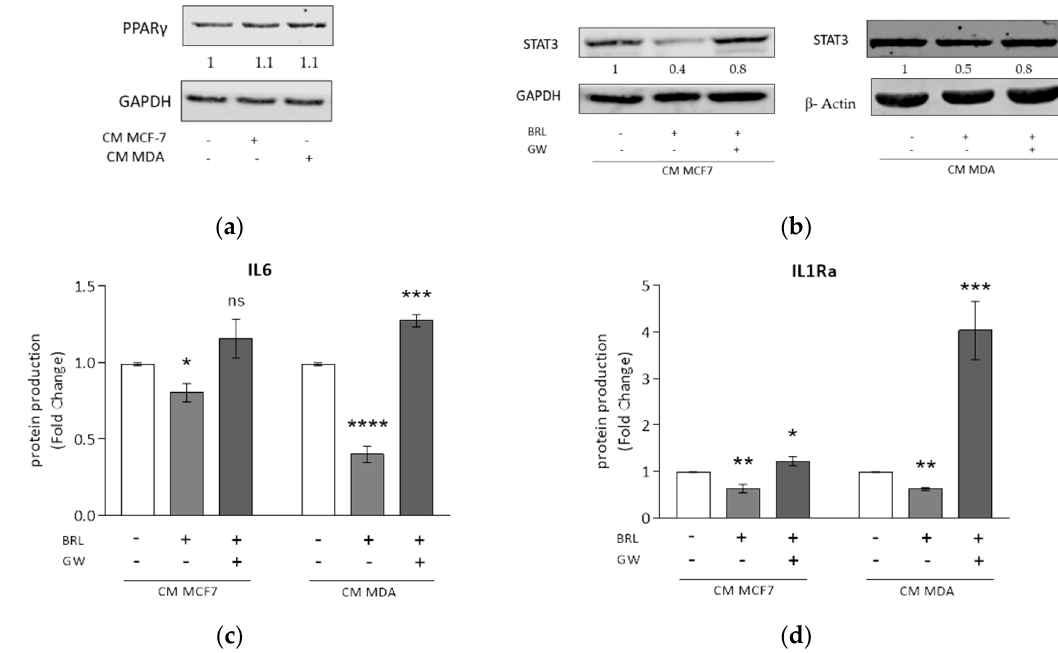
Figure 3. Rosiglitazone antagonizes macrophage cytokine secretion induced by conditioned media derived from MCF7 and MDA-MB-231 breast cancer cells. ( a ) Immunoblotting of PPAR γ in M0 macrophages (-) incubated with CM MCF7 or CM MDA for 72 h. Glyceraldehyde-3-phosphate dehydrogenase (GAPDH) was used as loading control. The blot is representative of three independent experiments, while the numbers below the blots represent the average fold change between PPAR γ and GAPDH protein expression with respect to M0 macrophages. ( b ) Immunoblotting of STAT3 in M0 macrophages incubated with CM MCF7 or CM MDA and treated with rosiglitazone (BRL) 10 μ M alone or in combination with GW9662 (GW) 10 μ M for 72 h. GAPDH or β -actin was used as the loading control. Each blot is representative of three independent experiments, while the numbers below the blots represent the average fold change between STAT3 and GAPDH or β -actin protein expression with respect to vehicle-treated cells. ELISA analyses of IL6 ( c ) and IL1Ra ( d ) proteins in M0 macrophages incubated with CM MCF7 or CM MDA, and treated with BRL 10 μ M alone or in combination with GW 10 µ M for 72 h. Data are expressed as means ± SDs of three independent experiments, each performed with duplicate samples. The results are expressed as fold changes with respect to vehicle-treated cells (-). * p < 0.05, ** p < 0.005, *** p < 0.0005, **** p < 0.0001, ns = not significant.